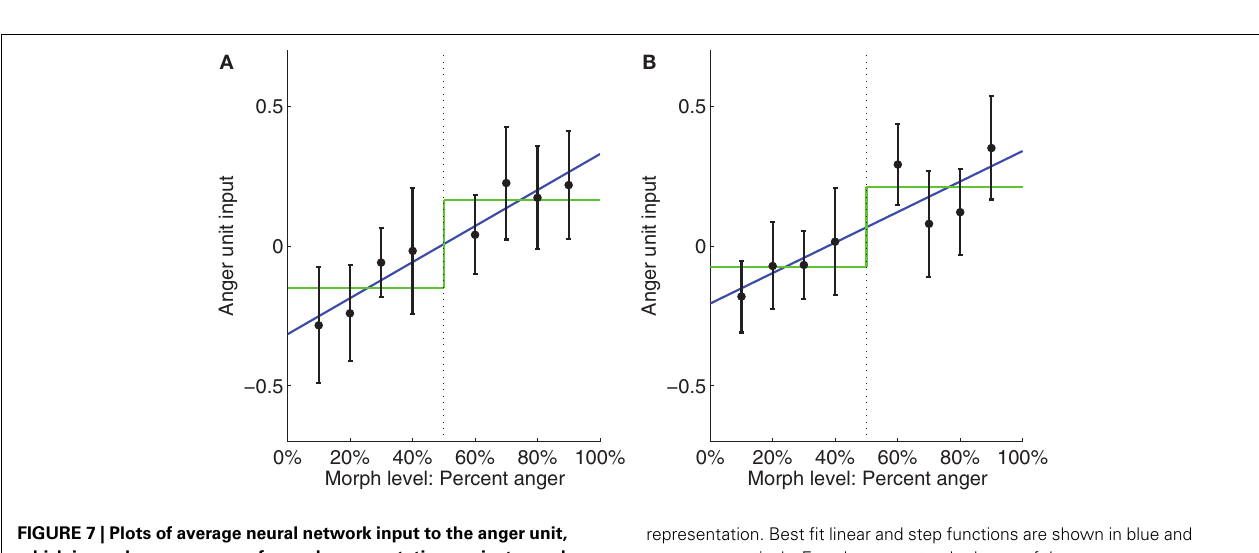
representation. Best fi t linear and step functions are shown in blue and green, respectively. Error bars are standard error of the mean across subjects. Throughout this report, k% anger implicitly means (100-k)% fear. (A) Left STS. (B) Right